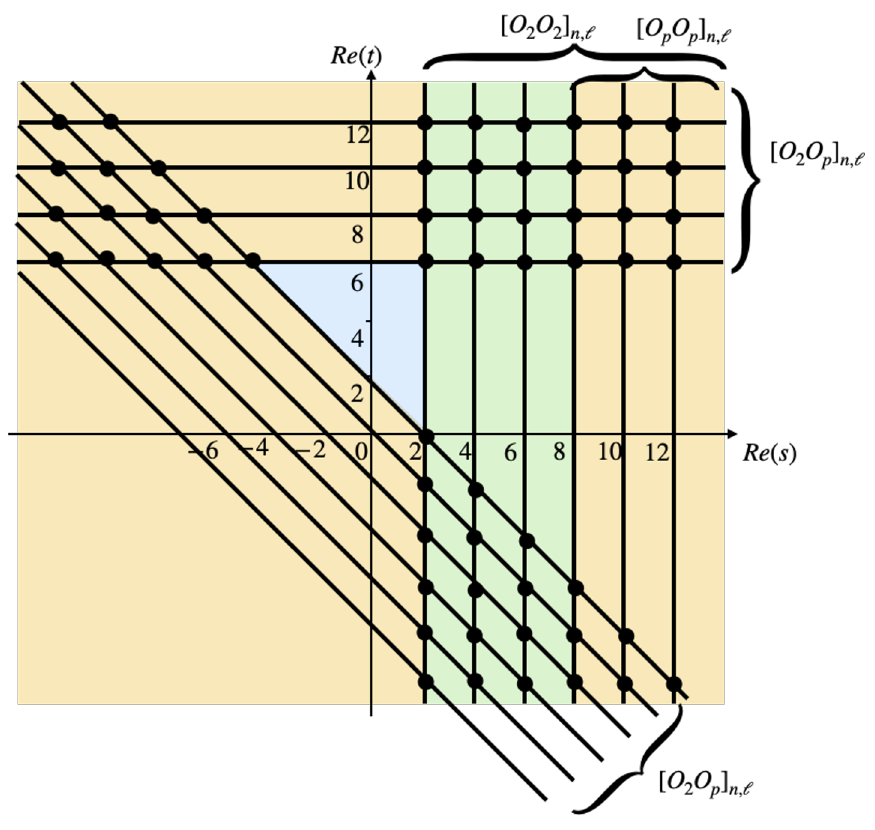
Figure 1 . Pole structures of the Mellin amplitude f M (2) (for the example of p = 4). The poles 22 pp of the Gamma functions are represented by the straight lines, and the simultaneous poles in the ansatz (3.7) are denoted by the dots at the intersections of the lines. The light blue region is where the poles of the tree level supergravity solution (2.48) sit, which is bounded by the Gamma function poles. We have used the green color for the region 2 (cid:20) Re ( s ) < 8 to emphasize that the two series of Gamma function poles do not overlap in this region, which corresponds to the long